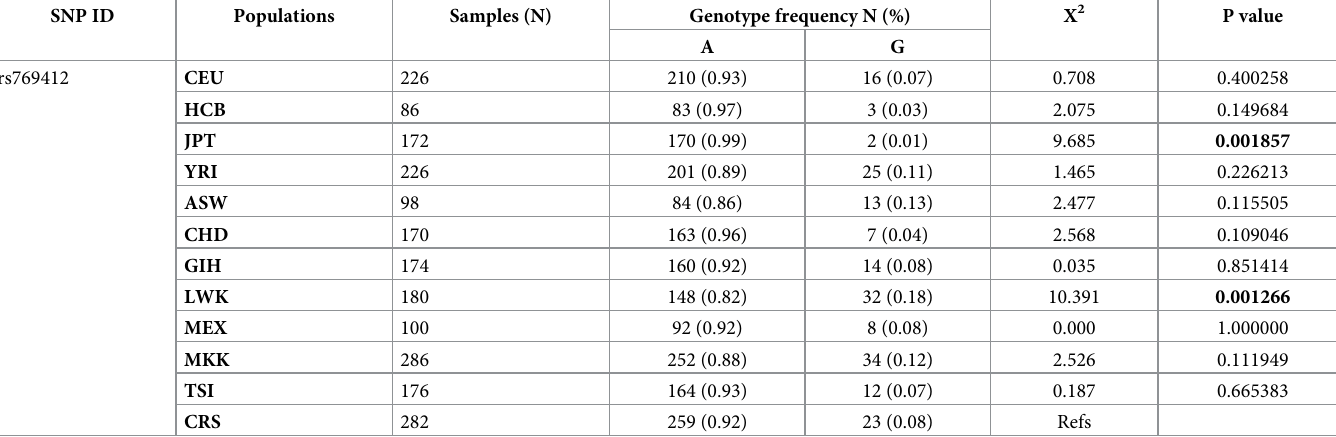
Table 10. Genotype frequency of MDM2 polymorphism in the Saudi population compared with other populations. SNP